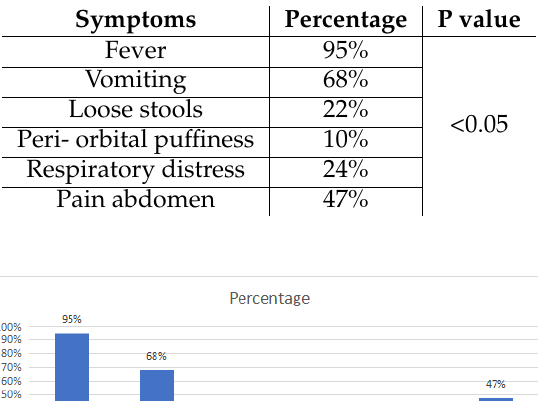
Table 2. Evaluation of clinical findings